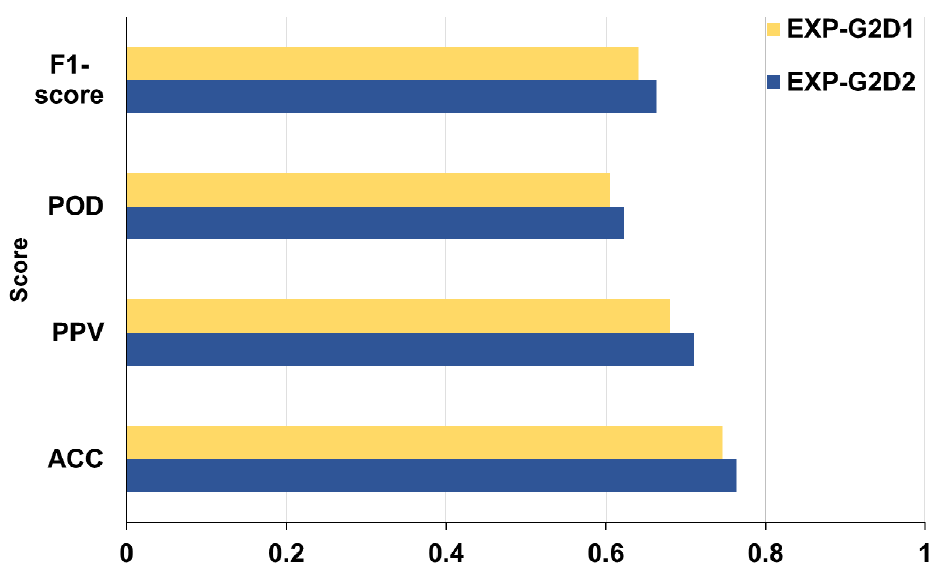
Figure 6. F1-score, POD, PPV, and ACC for EXP-G2D1 and EXP-G2D2.